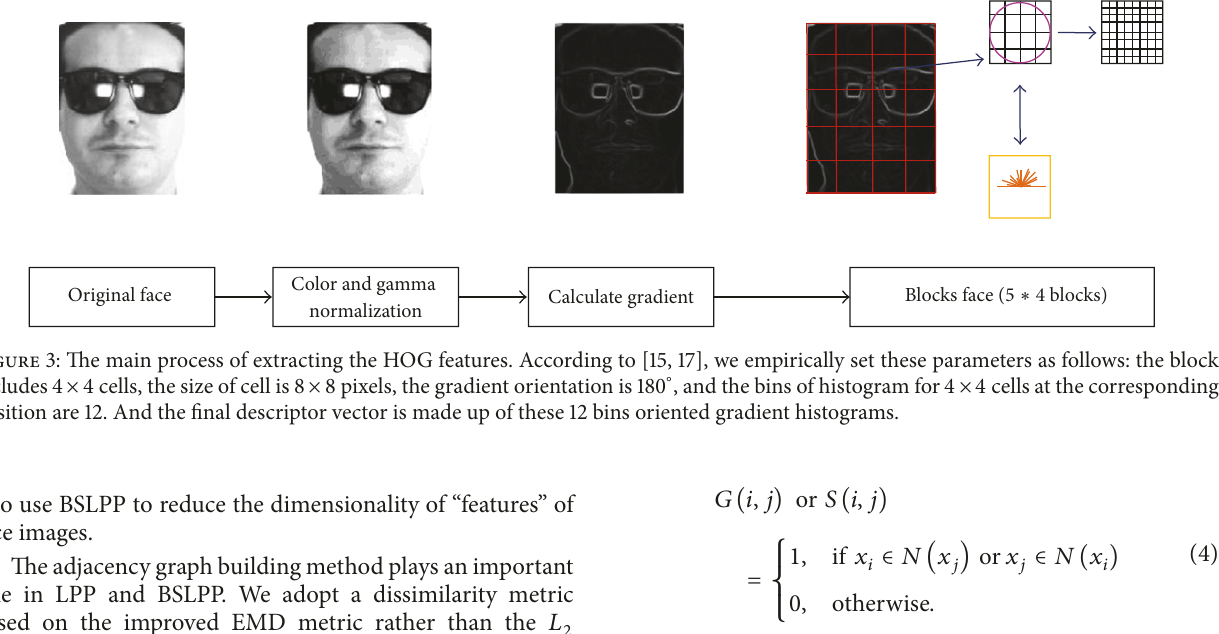
also use BSLPP to reduce the dimensionality of “features”